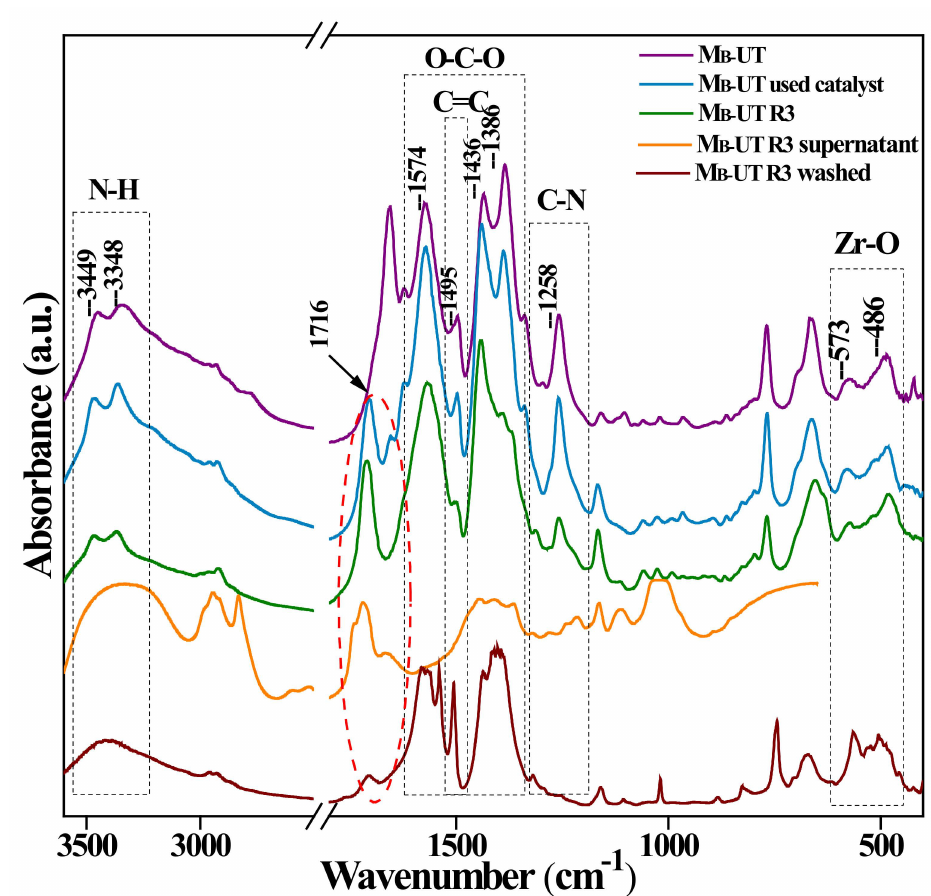
Figure 7. FTIR spectra for the fresh, used catalysts and supernatant